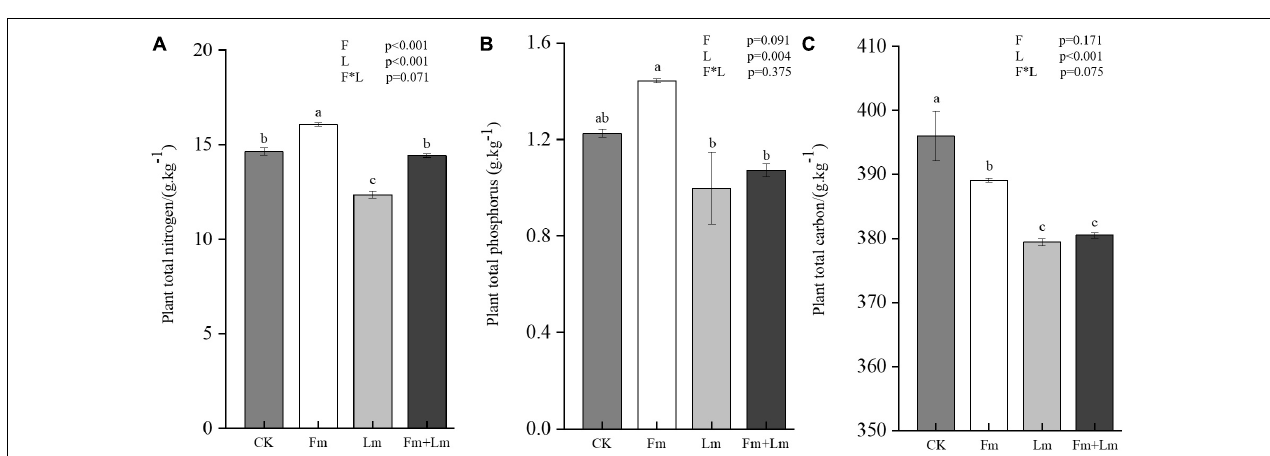
FIGURE 2 | Plant aboveground biomass (A) and belowground biomass (B) under different treatments. The four treatments were (1) CK: no inoculation; (2) Fm: inoculated with F. mosseae only; (3) Lm: feeding with L. migratoria only; (4) Fm + Lm: inoculated with F. mosseae and L. migratoria feeding. Values are means ± standard error. P -values for inoculation and insect feeding effects were based on two-way ANOVA, F: inoculated AMF; L: insect feeding. Mean values followed by the same letter do not differ significantly at P ≤ 0.05 by DMRT.